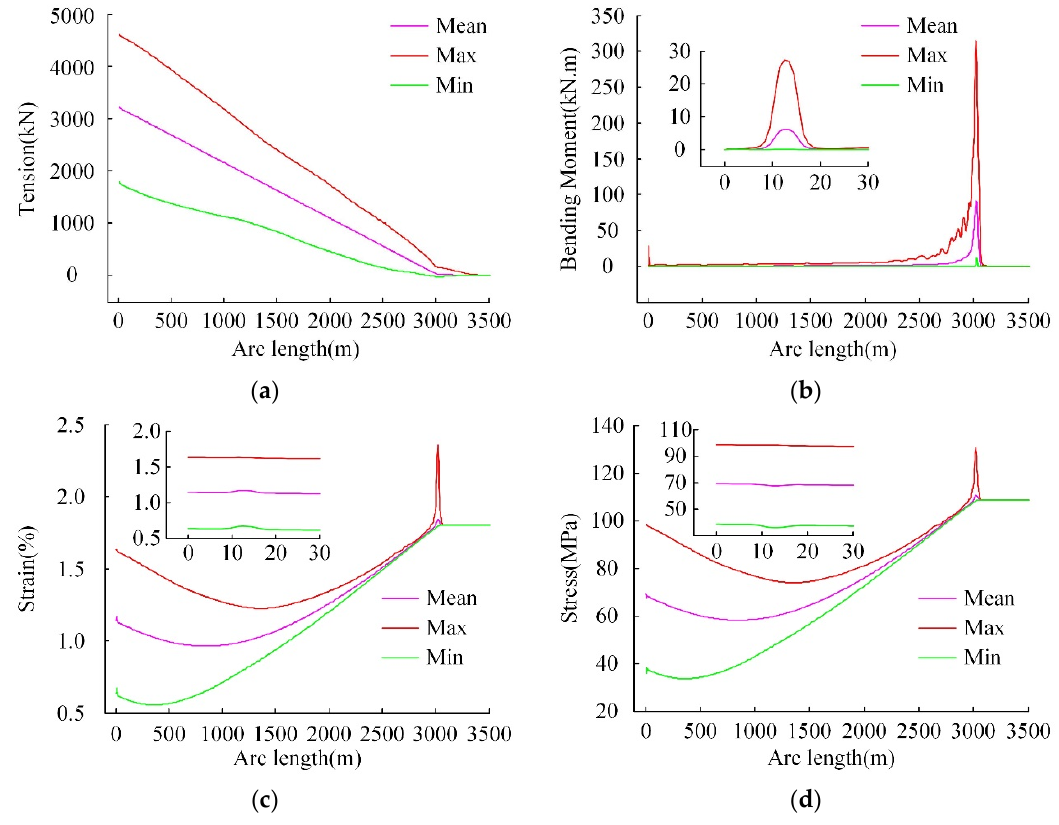
Figure 8. Dynamics behavior of the pipeline: ( a ) Axial tension; ( b ) Bending moment; ( c ) Strain; ( d ) Stress.